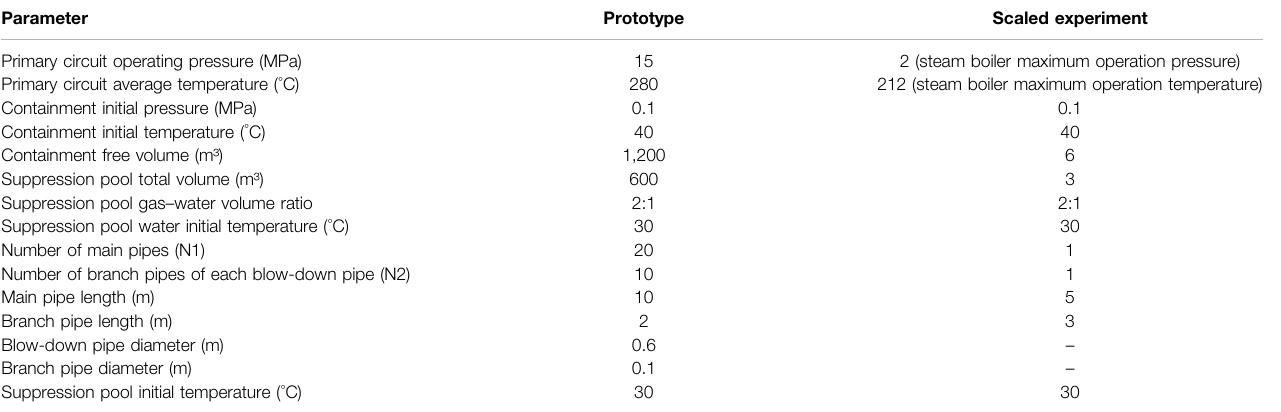
TABLE 1 | Main parameters of the prototype and scaling experimental